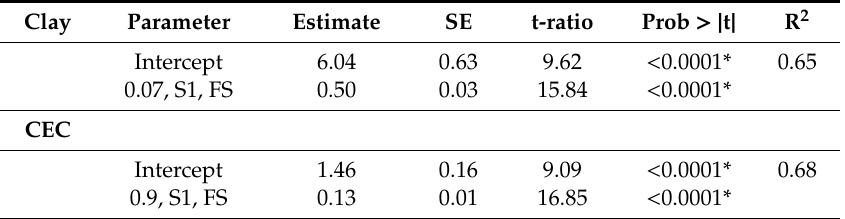
Table 6. Summary statistics of the linear regression (LR) model established between the calculated true electrical conductivity ( σ ) and measured clay (%) and CEC (cmol( + ) / kg). The σ was estimated using the full solution (FS), S1 algorithm and a damping factor ( λ ) of 0.07 and 0.9 respectively.